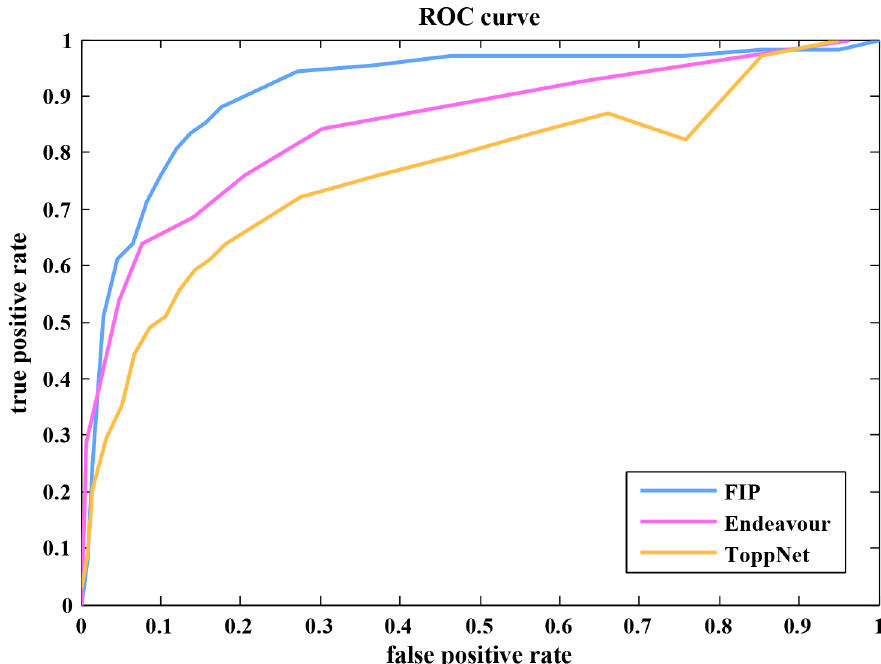
Fig 8. The ROC curves of FIP, ToppNet, and Endeavour